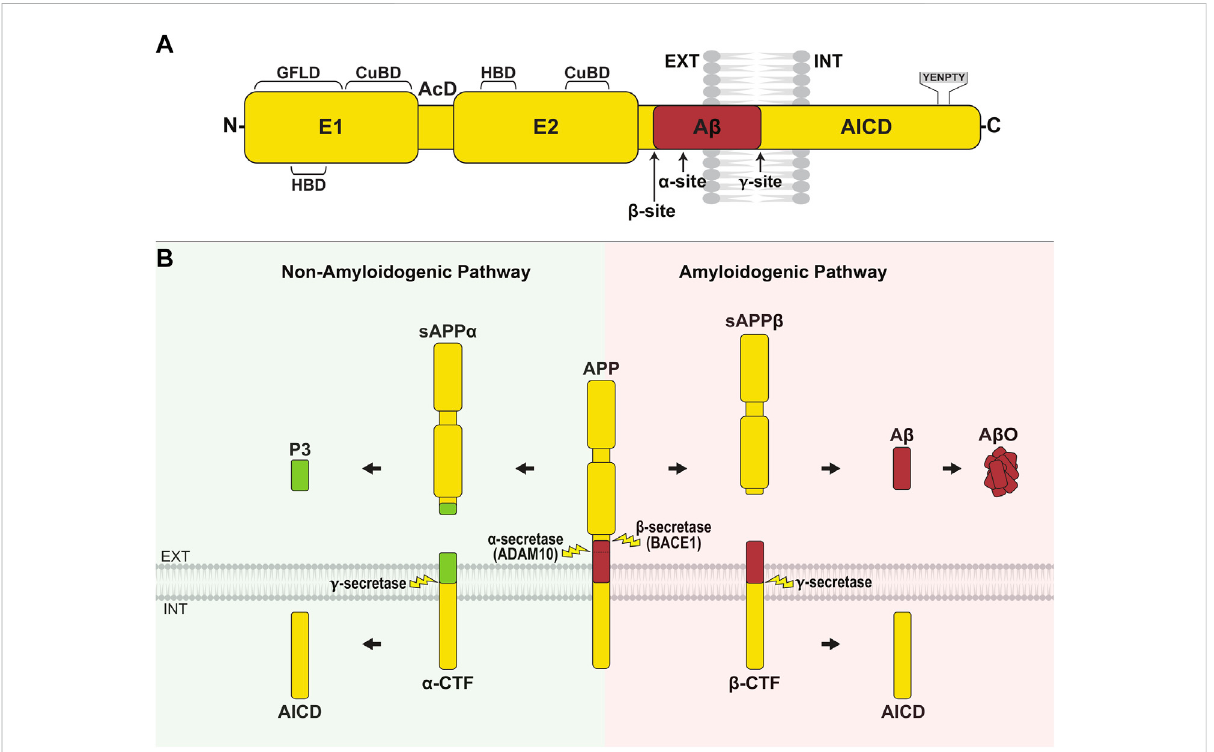
FIGURE 1 APP structure and processing. (A) APP is composed of a large N-terminal extracellular domain, transmembrane region, and short cytoplasmic tail. Theextracellulardomaincomprisestworigidlyfoldedregions,E1andE2,joinedbyanacidicdomain(AcD).E1containsaheparin-bindingdomain(HBD) within a larger growth factor-like domain (GFLD), and a copper/zinc-binding domain (CuBD). E2 comprises the second HBD and CuBD. The juxtamembraneregioncontainsthe α -and β -cleavagesites,whilethe γ -cleavagesiteislocatedwithinthetransmembranedomain.TheC-terminal intracellular domain (AICD) contains the YENPTY sequence, which binds cytosolic adaptor proteins. (B) APP is primarily processed along two opposing pathways.Inamyloidogenicprocessing, APPiscleavedby β -secretase(BACE1)attheN-terminusofA β ,generatingsAPP β andthemembrane-bound β - CTF. Subsequent γ -secretase cleavage of β -CTF releases the A β peptide into the extracellular/lumenal space and AICD into the cytosol. A β peptides aggregateandformoligomers(A β O).Innon-amyloidogenicprocessing,APPiscleavedby α -secretase(ADAM10)withintheA β region,producingsAPP α and α -CTF. Ensuing cleavage of α -CTF by γ -secretase liberates P3 into the extracellular/lumenal space and AICD into the